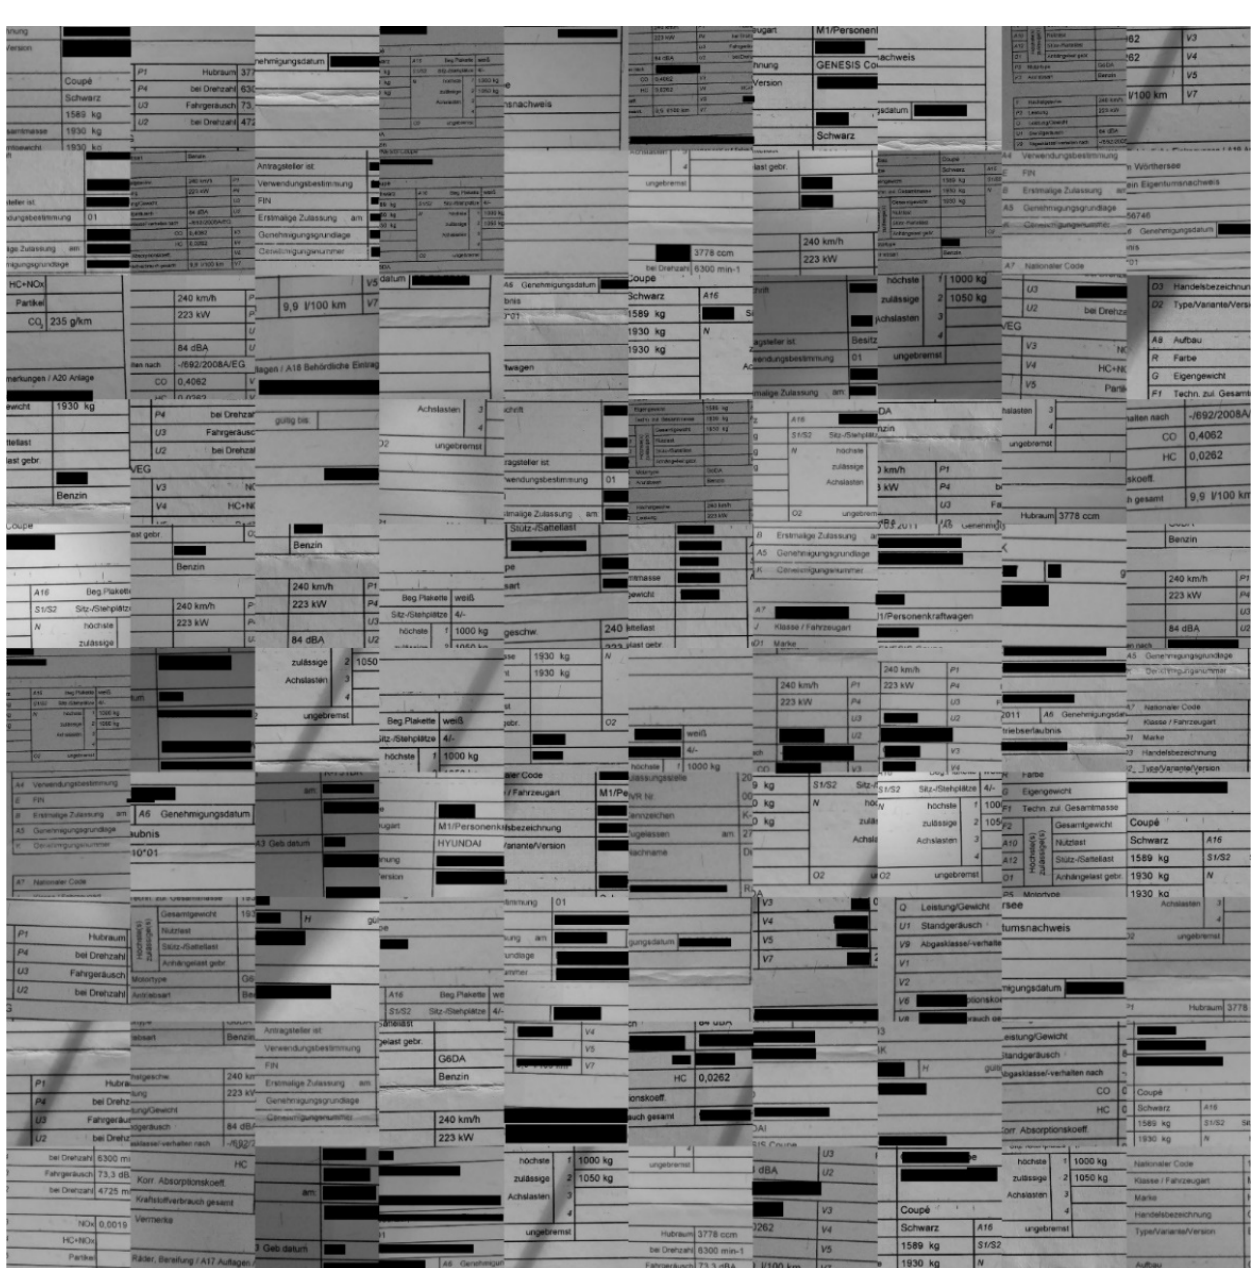
Figure 9. These are 100 “good quality” sample data extracted from our own dataset (an extract from a much bigger dataset). Note: since the images contain some personal data, those parts are covered by black rectangles for privacy